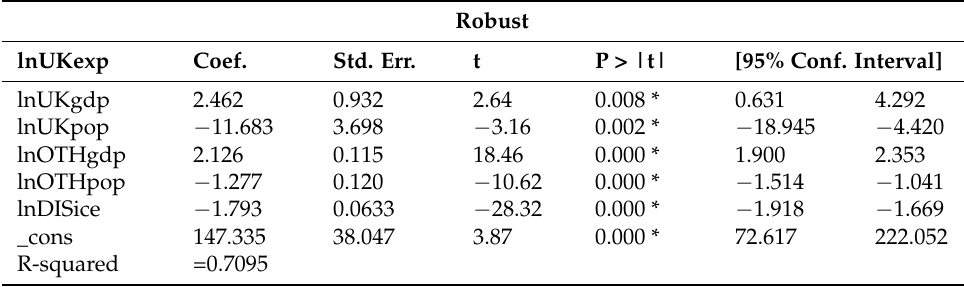
Table 4. Regression for Iceland exports, using robust standard errors with variable treated with the logarithm function. Robust lnUKexp Coef. Std. Err. t P > |t| [95% Conf. Interval] lnUKgdp 2.462 0.932 2.64 0.008 * 0.631 4.292 lnUKpop − 11.683 3.698 − 3.16 0.002 * − 18.945 − 4.420 lnOTHgdp 2.126 0.115 18.46 0.000 * 1.900 2.353 lnOTHpop − 1.277 0.120 − 10.62 0.000 * − 1.514 − 1.041 lnDISice − 1.793 0.0633 − 28.32 0.000 * − 1.918 − 1.669 _cons 147.335 38.047 3.87 0.000 * 72.617 222.052 R-squared